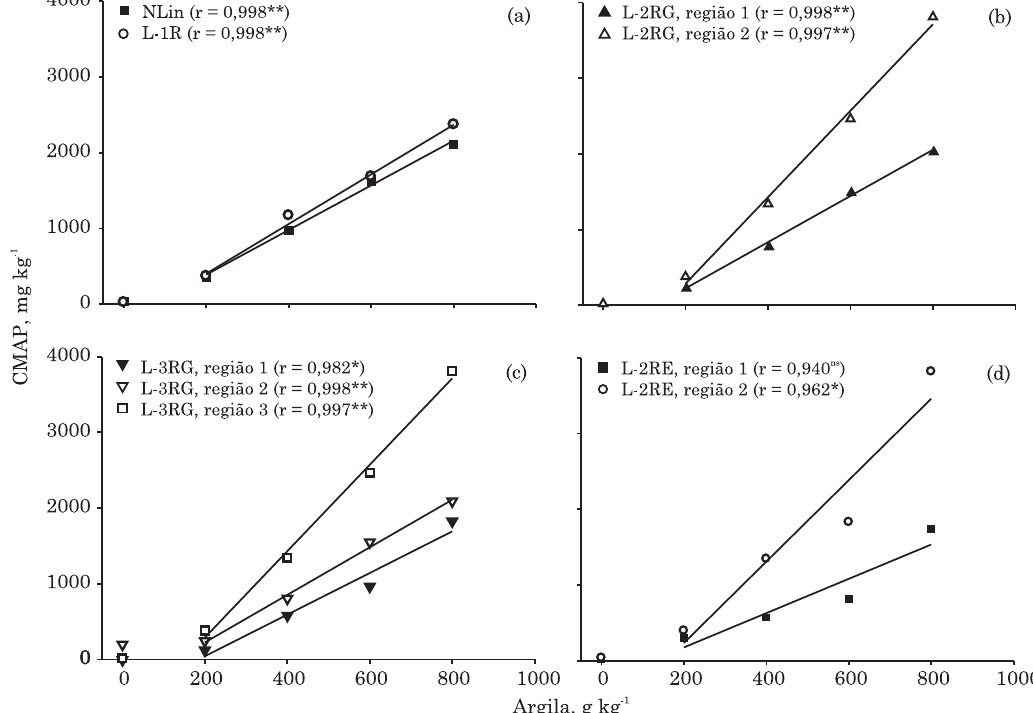
Figura 3. Relação entre o teor de argila do solo e a capacidade máxima de adsorção de fósforo (CMAP) em solos com diferentes teores de argila. Modos de ajuste do modelo: NLin = não linear com região única e L-1R = linearização com região única (a); L-2RG = linearização com duas regiões, ajuste gráfico (b); L-3RG = linearização com três regiões, ajuste gráfico (c); e L-2RE = linerização com duas regiões, ajuste estatístico (d). Por ser uma amostra composta apenas por areia, o tratamento “0 g kg -1 argila” foi excluido da análise de correlação. *: p<0,05; **: p<0,01; e ns: